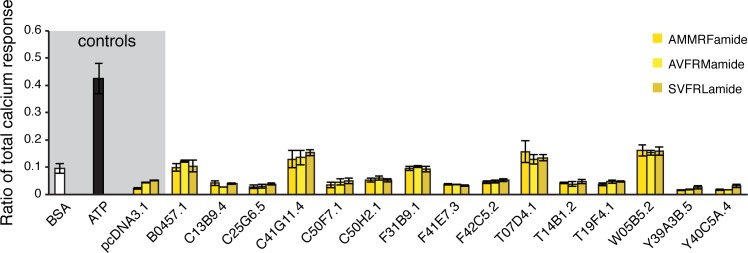
Screen for a FLP-20 AIY expressed receptor.Calcium responses measured in Chinese hamster ovary (CHO) cells transfected with an empty pcDNA3.1 vector or with a pcDNA3.1::receptor construct. Calcium responses after the administration of FLP-20 peptides are plotted as a ratio to the total calcium response (peptide-evoked + Triton-X-100- evoked responses). Bovine serum albumin (BSA) medium, containing no peptides, was used as a negative control. ATP, which activates an endogenous CHO receptor, was used as a positive control. BSA and ATP responses are averaged for all transfected constructs. Error bars indicate SEM (n ≥ 2).